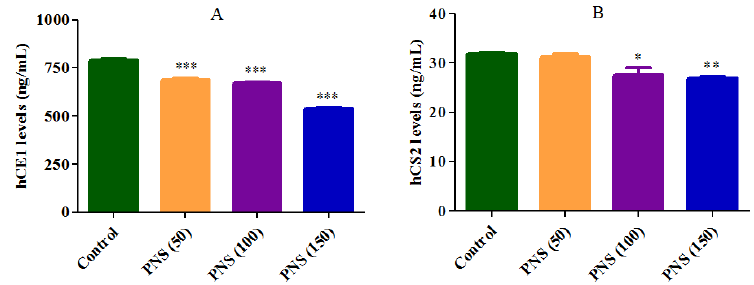
Figure 8. Effects on human carboxylesterase 1 (hCE1) ( A ) and hCE2 ( B ) protein level following Panax notoginseng saponins (PNS) treatment. Cells were incubated with PNS for up to 24 h. After the removal of PNS, cell lysates were prepared for ELISA analysis. Data were presented as mean ± SD ( n = 3). *, **, and *** denoted results significantly different from those of the control group ( p < 0.05, p < 0.01, and p < 0.001, respectively).